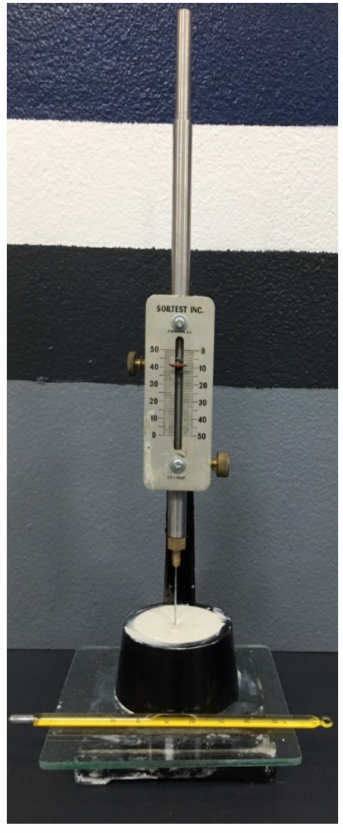
Figure 5. Vicat needle test